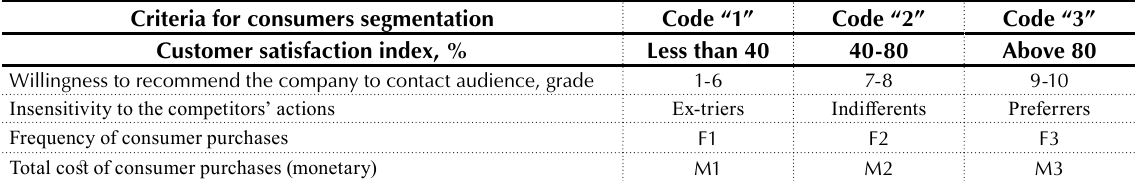
Table 3. Segmentation of consumers